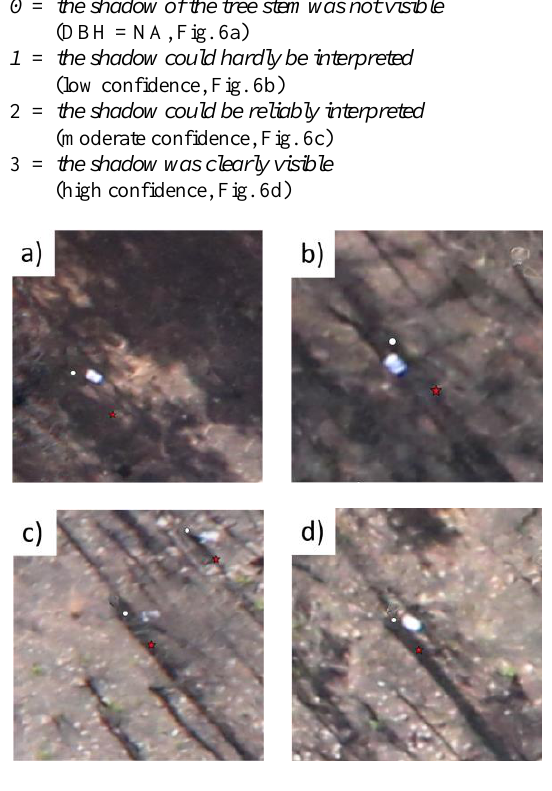
Figure 6. Examples of the four confidence levels used for grading the DBH measurements; i.e. DBH not measureable = 1 (a), estimated with low confidence = 2 (b), estimated with moderate confidence = 3 (c), estimated with high confidence = 4 (d). White points show the position of the tree stem and red points indicate DBH position (1.3 m) projected on the ground.